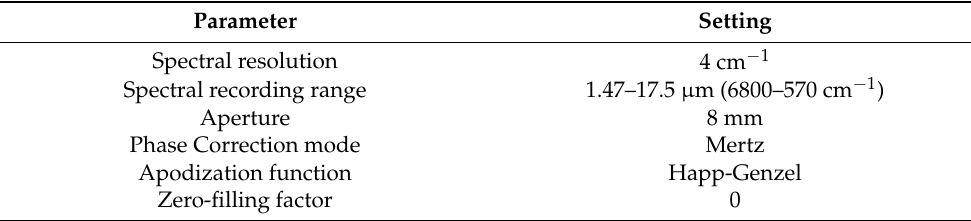
Table A3. Standard measurement settings for the setup at